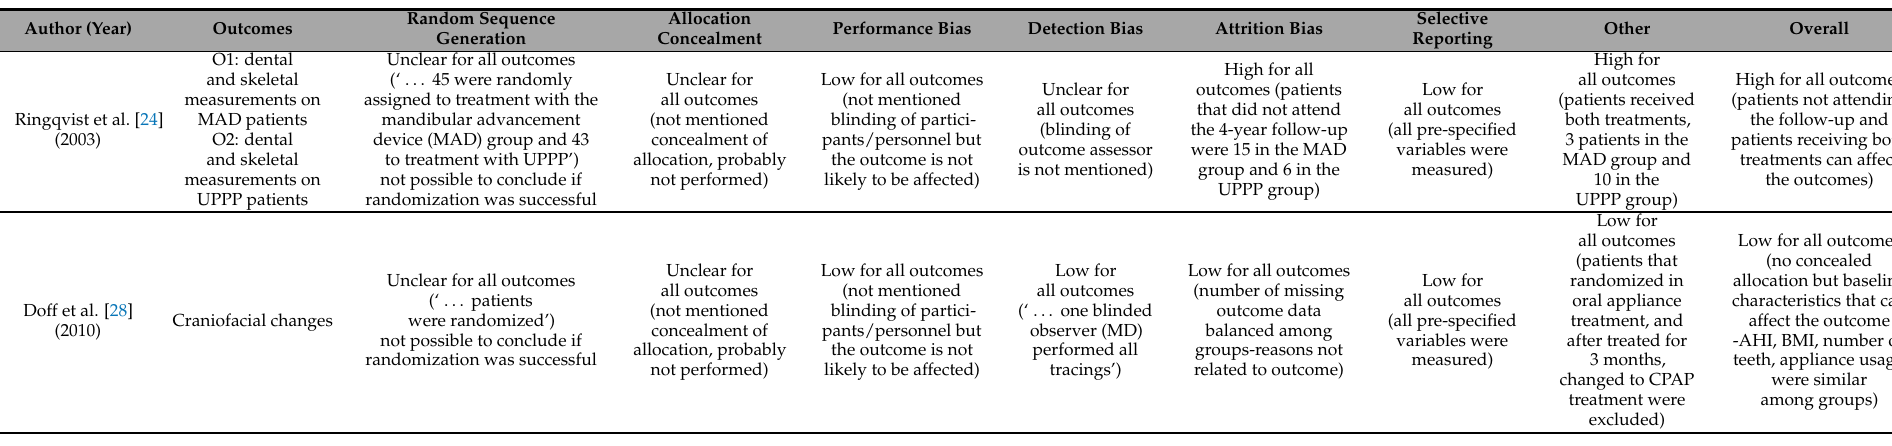
Table 4. Risk of bias assessment for randomized clinical trials. Abbreviations: CPAP—continuous positive airway pressure, MAD(s)—mandibular advancement device(s), UPPP—uvulopalatopharyngoplasty.